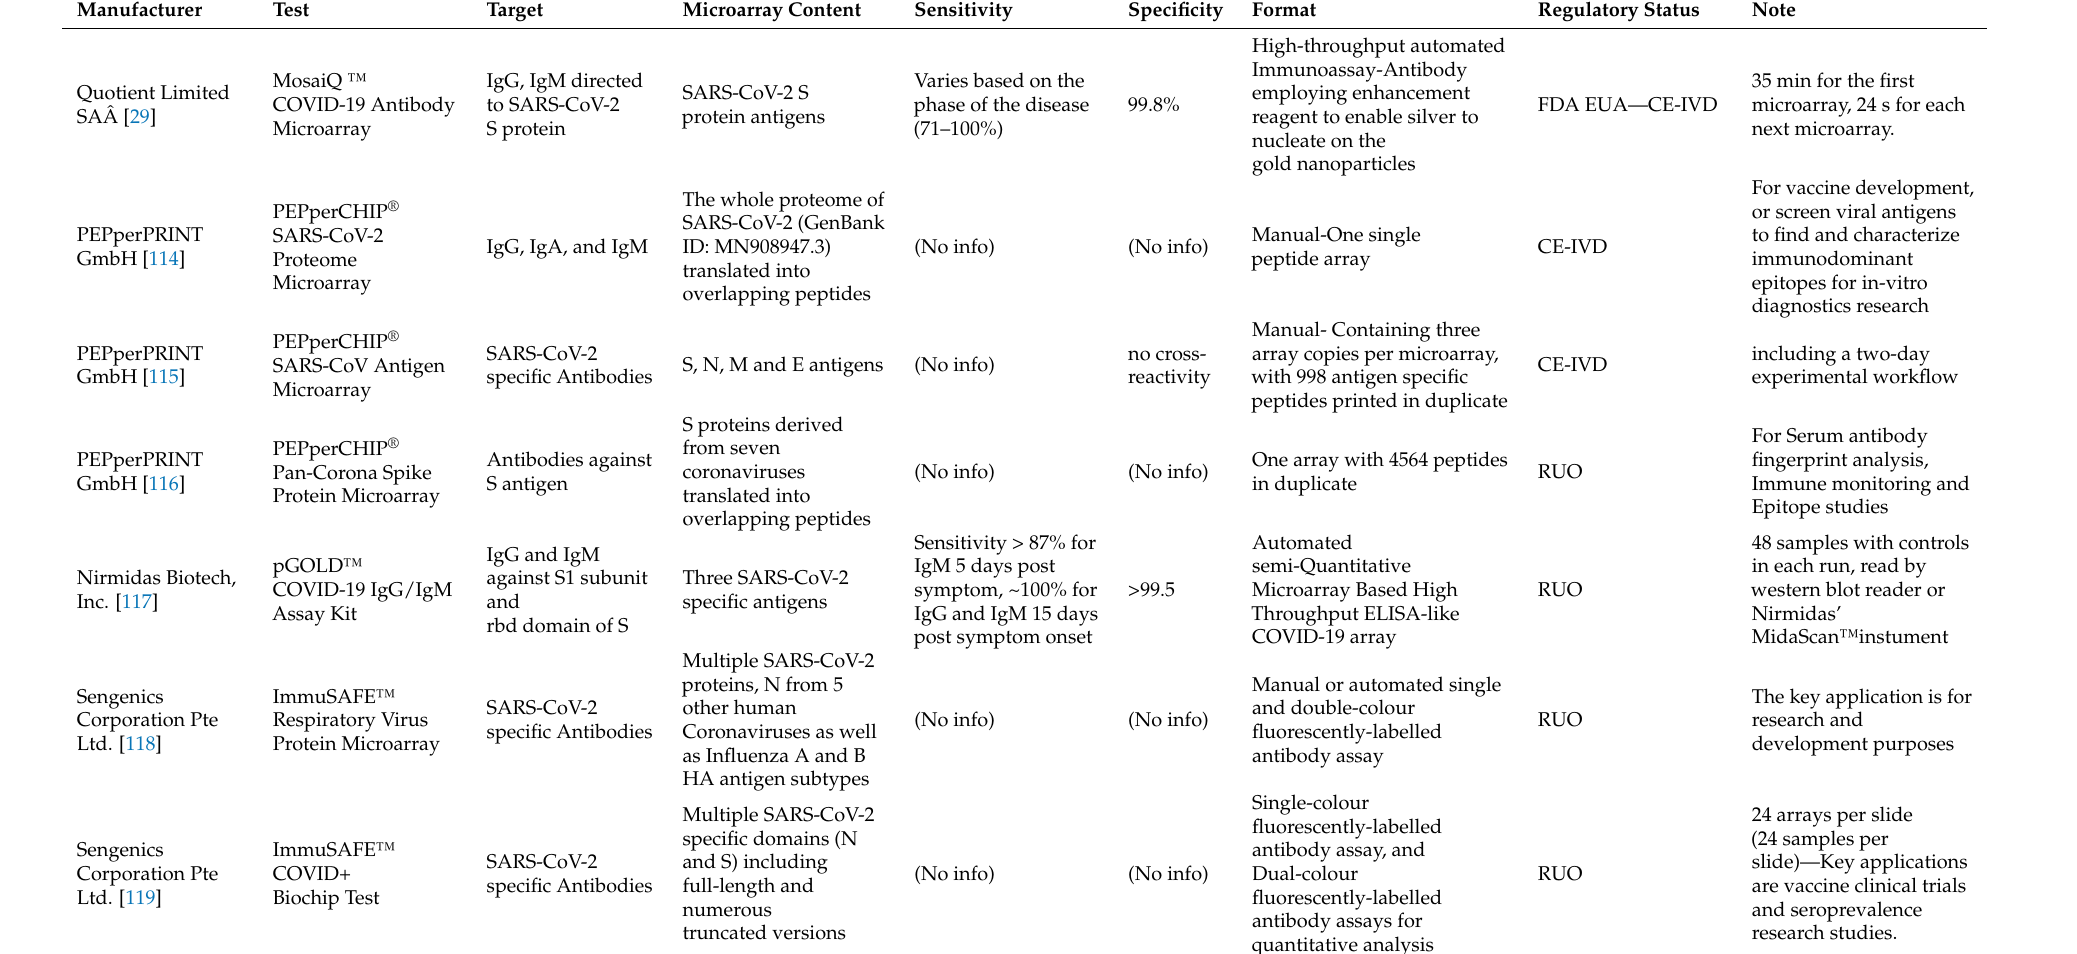
Table 4. The developed protein microarray-based tests for COVID-19